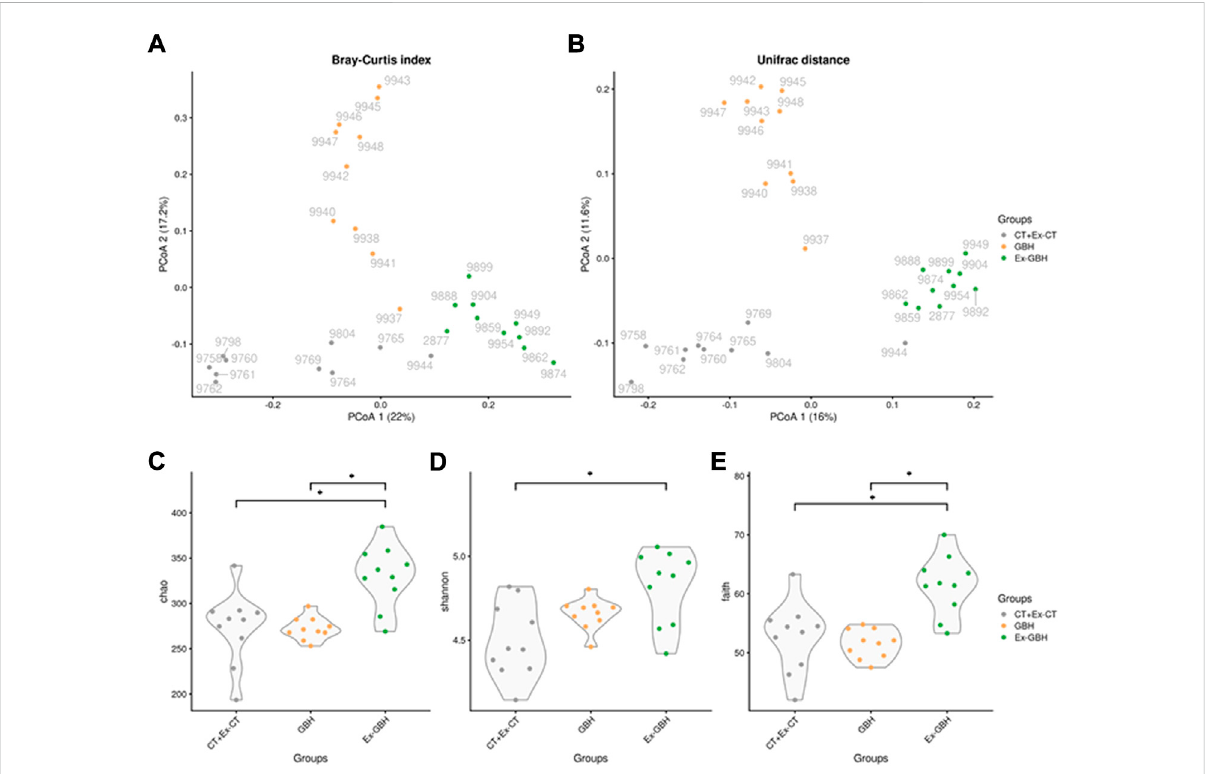
FIGURE 6 Microbiome β -diversity in cecal content of hens exposed to GBH for 42 days (GBH, n = 9), then non-exposed until D70 (Ex-GBH, n = 12) and controls at D42 and D70 taken together (CT + Ex-CT, n = 10), collected during (D42) and after GBH exposure (D70) measured by principal coordinates analysis (PCoA) on Bray – Curtis index (A) and Unifrac distance (B) . Results are presented as individual values. Microbiome α -diversity in the very same groups measured by Chao (C) , Shannon (D) and Faith indices (E) . *p ≤ 0.05. CT + Ex-CT: Control and ex-Control taken together, GBH: Glyphosate-Based Herbicide,